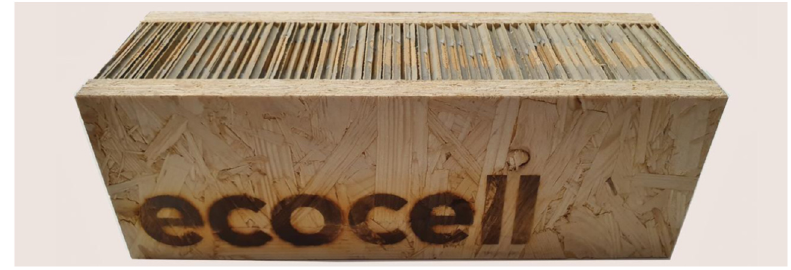
Figure 4. ECOCELL [8].